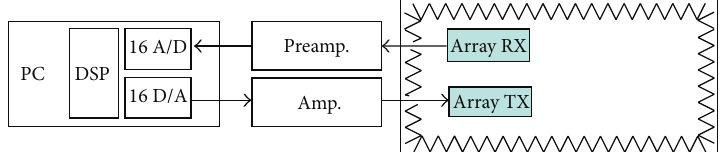
Figure 3: Hardware architecture block diagram.